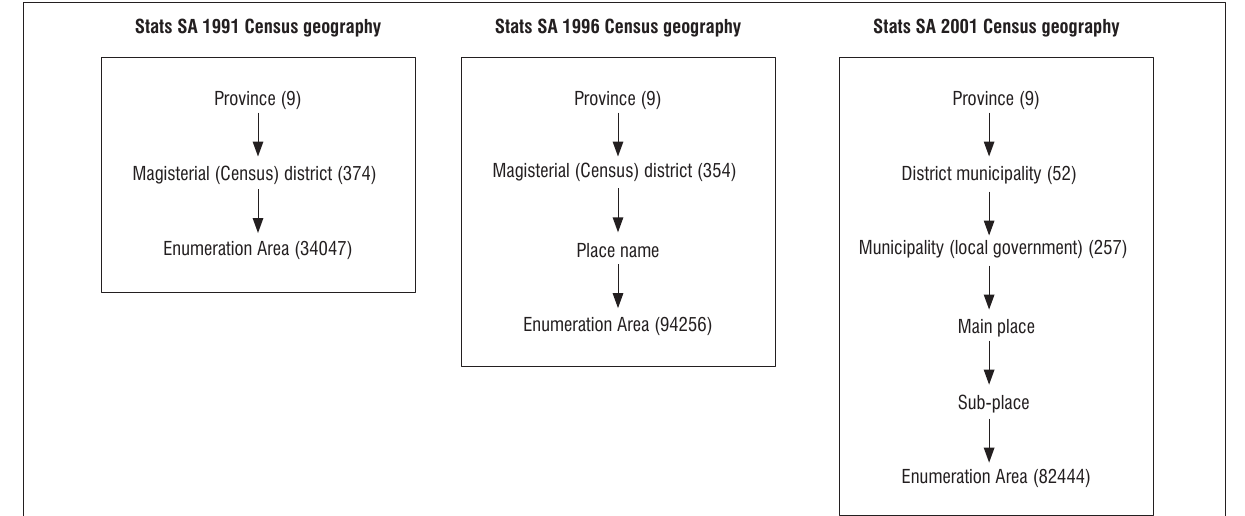
Figure 1: Spatial hierarchy of various